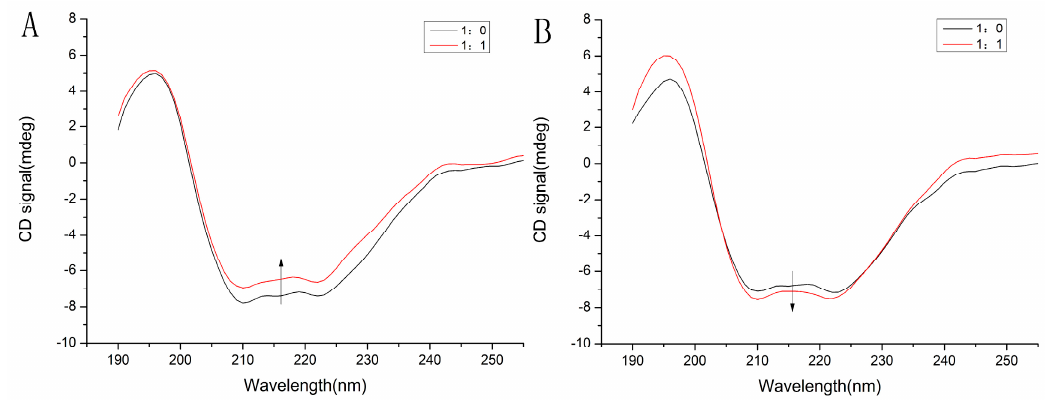
Figure 5. Far-UV circular dichroism (CD) spectra of HSA–TF ( A ) and GHSA–TF ( B ). Table 3. Secondary structure assignment of various conformational states of HSA / GHSA in the presence of TF.